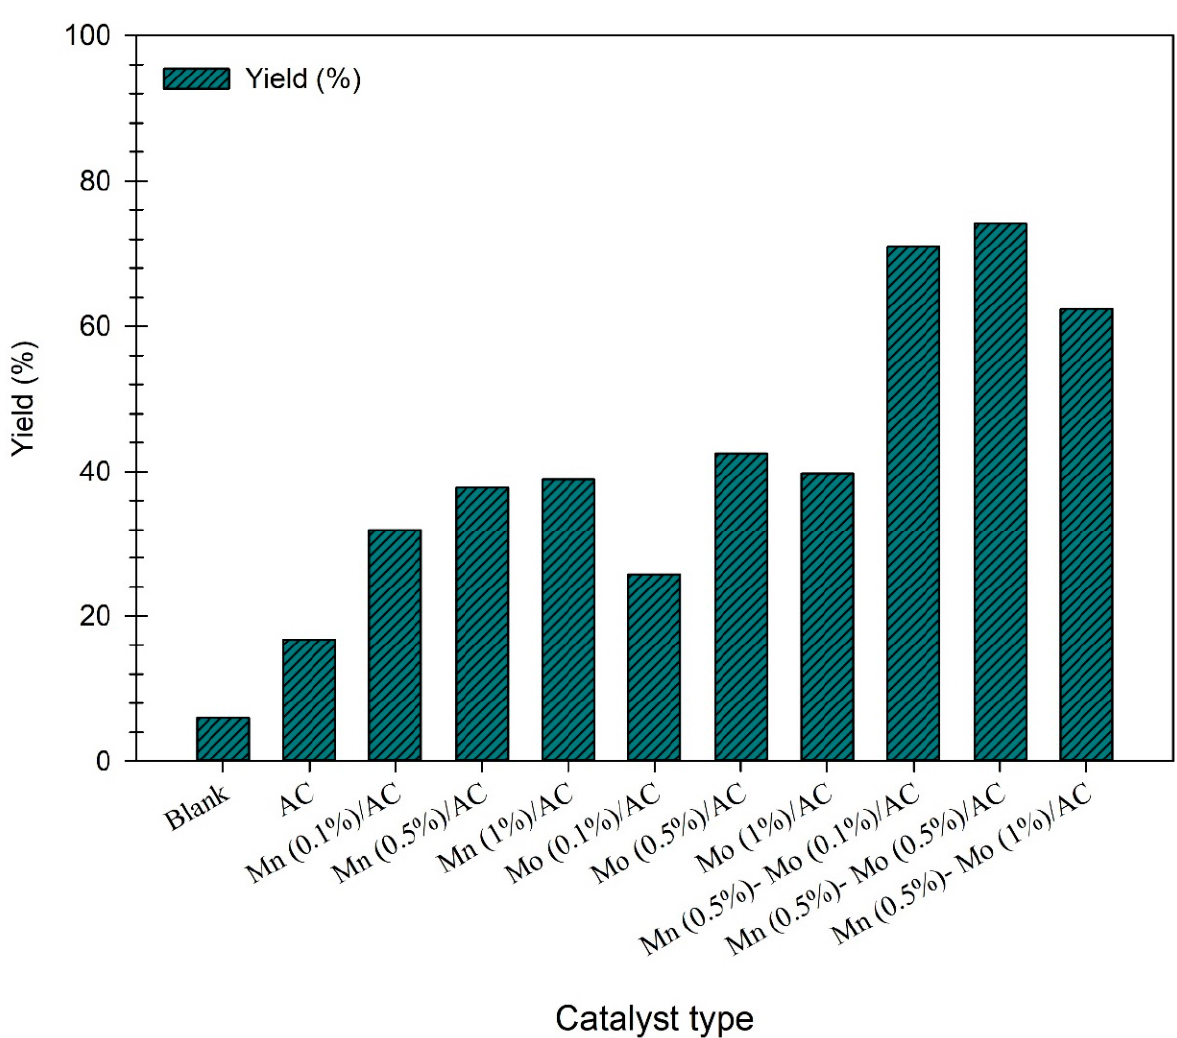
Figure 5. Deoxygenation reaction screening of SPO over supported catalyst.